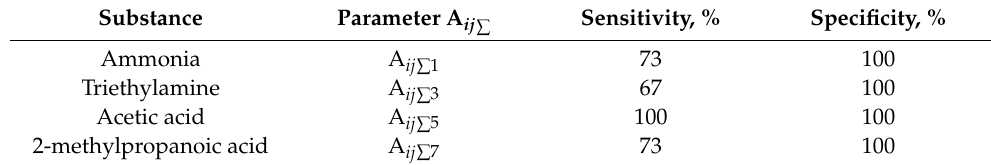
Table 13. Sensitivity and specificity of VOC identification by A ij ∑ parameters in model mixtures. Substance Parameter A ij ∑ Sensitivity, % Specificity,